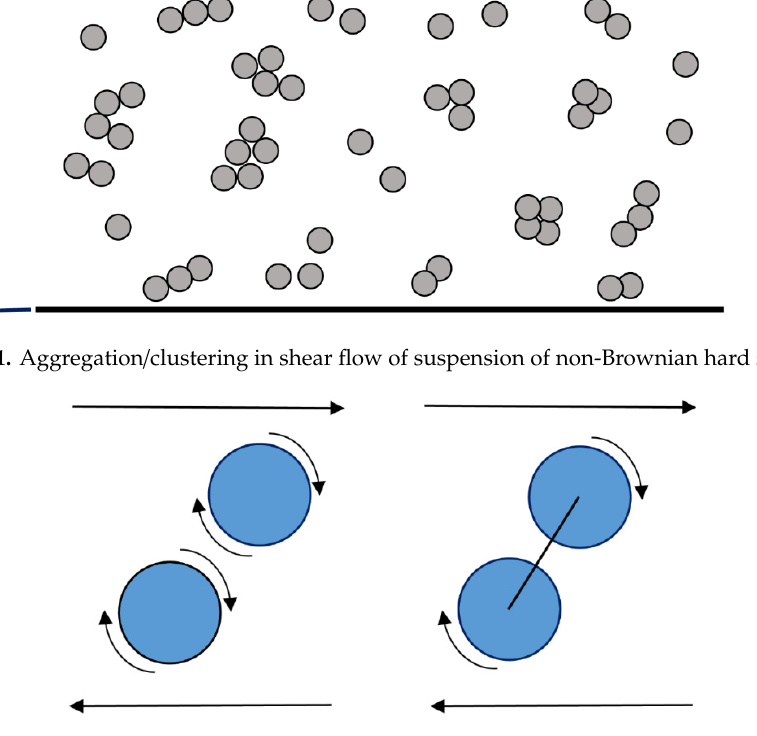
Figure 3. Effective volume of clusters of particles . The shaded area outside the particles represents the immobilized matrix liquid. The number and size of aggregates are expected to grow with the increase in the particle concentration. The aggregation of particles with the increase in particle concentration is shown schematically in Figure 4. Figure 4. Variation in microstructure of suspension with successive addition of particles.